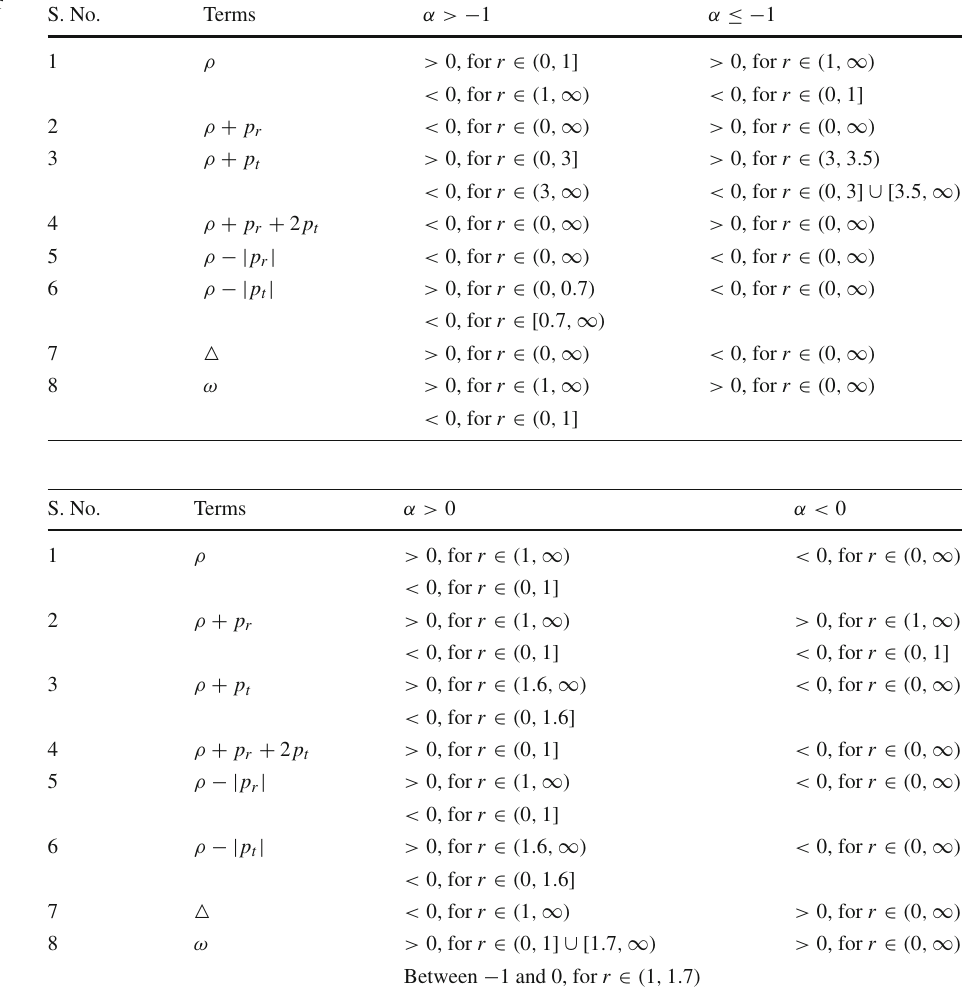
Table 9 Summary of results for φ( r ) = log ( r 0 + 1 ) with n = 1 r